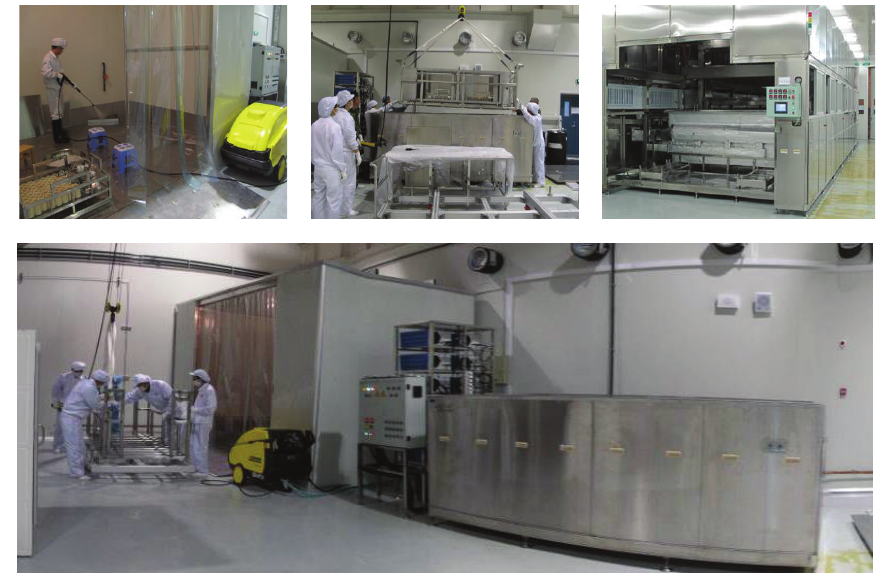
Figure 3: Small-batch production line for LRU